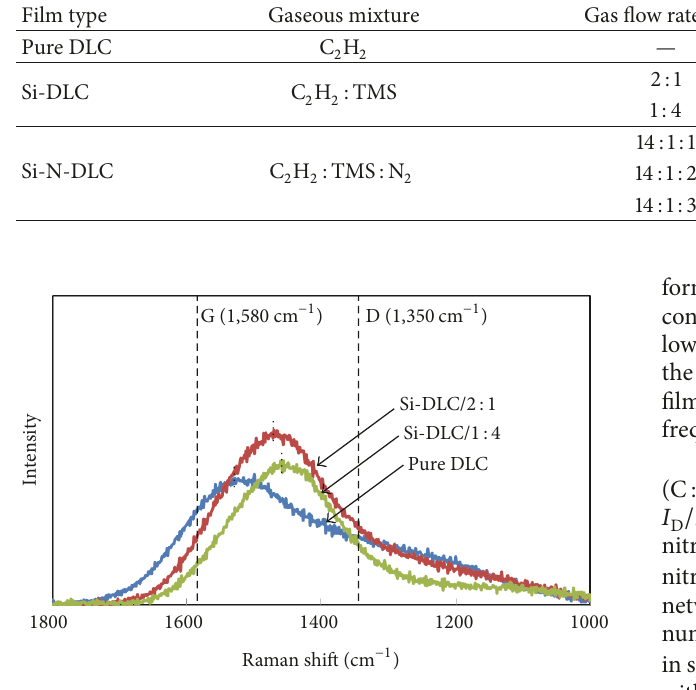
Figure 2: Raman spectra of the DLC and Si-DLC films, at various flow rate ratios.